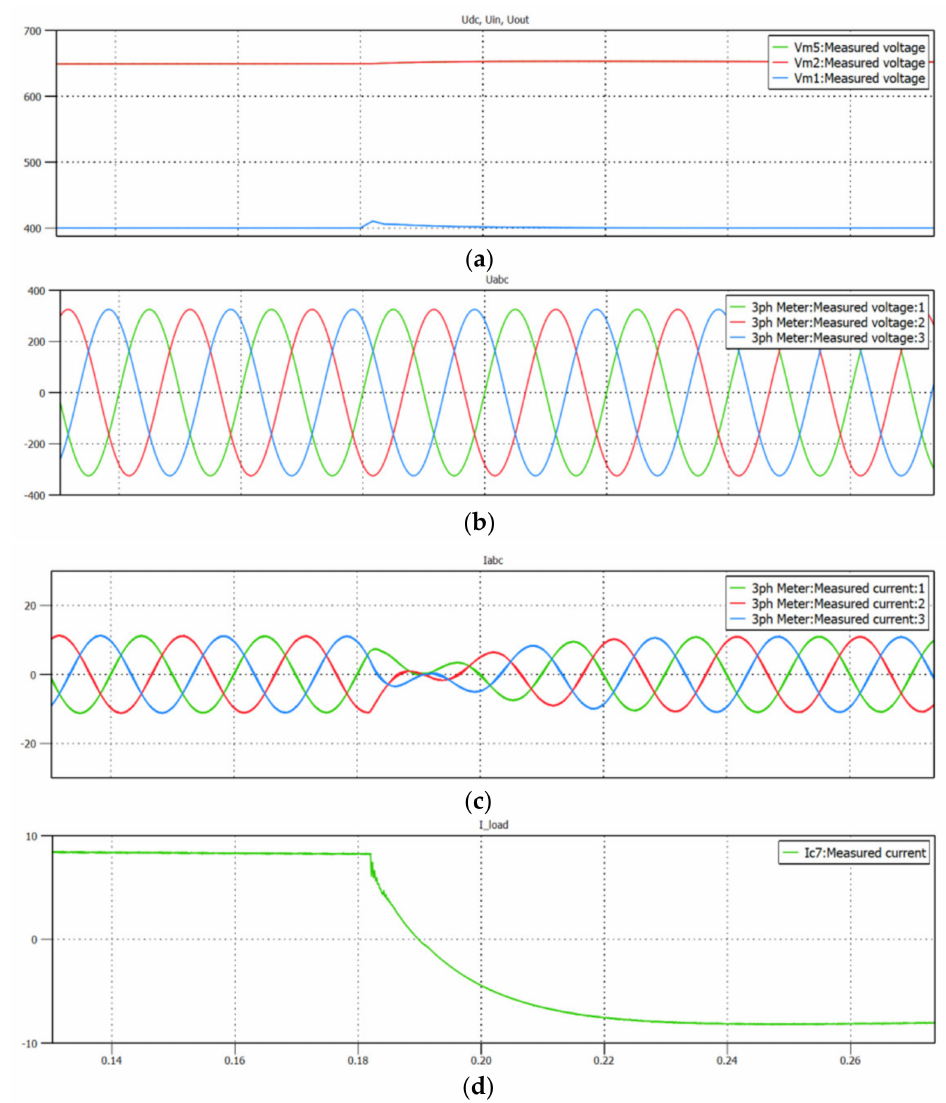
Figure 10. Simulation result—step change of bi-directional direct-current fast charger from charging operation mode to battery discharging operation mode: ( a ) DAB’s input voltage (red), DAB’s output voltage (battery voltage)—blue; ( b ) grid phase voltages; ( c ) grid phase currents; ( d ) battery current